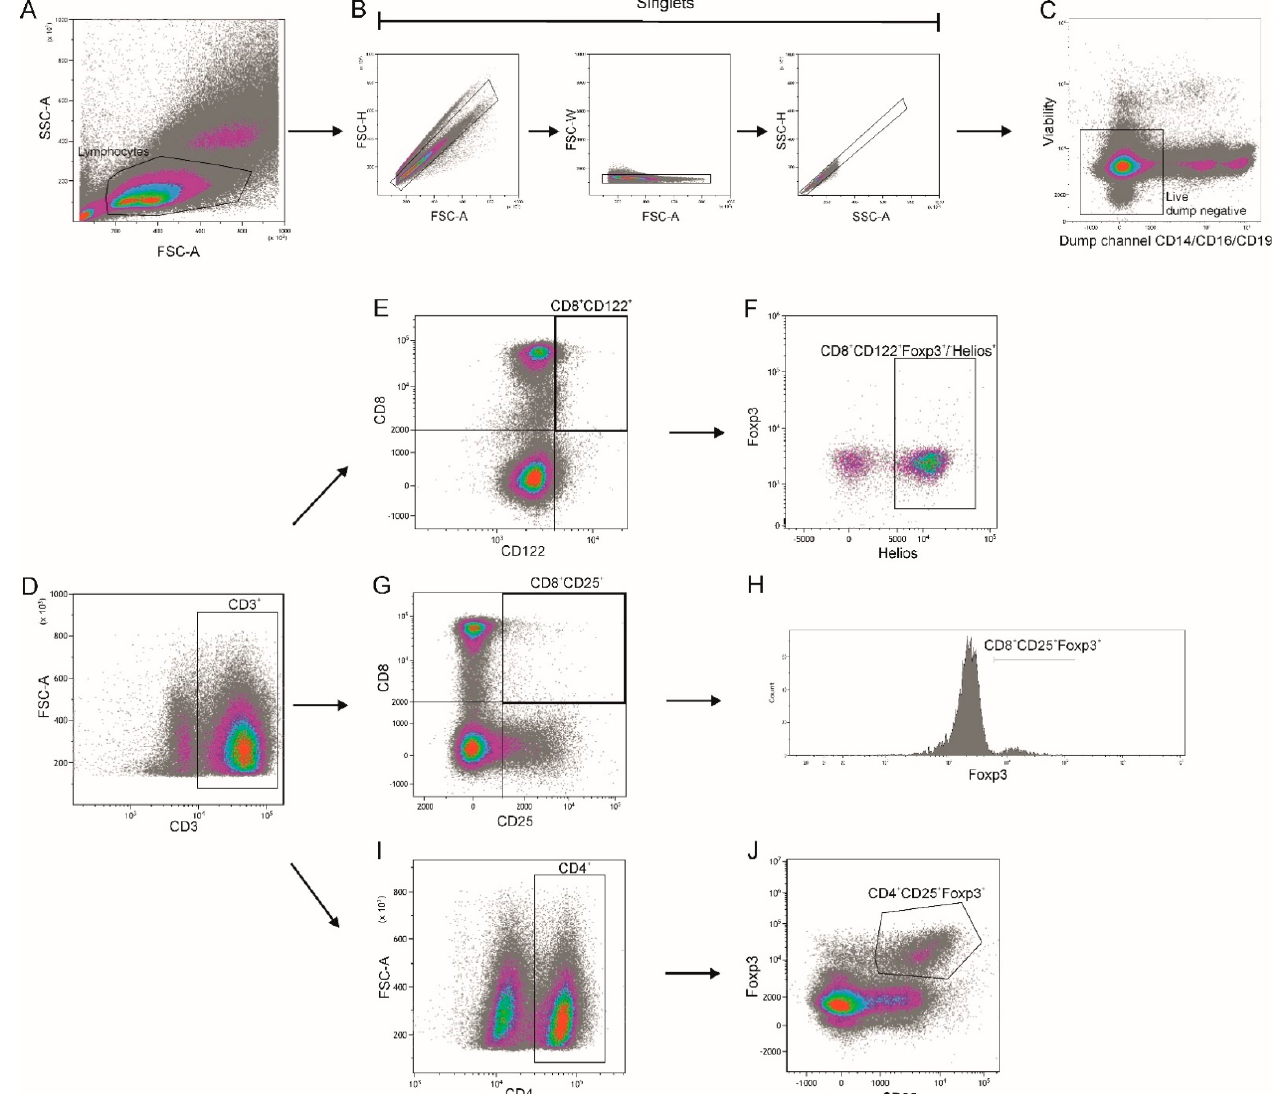
Figure 1. Gating strategy for CD4+ and CD8+ Treg populations. Gating strategy for flow cytometric analysis of lymphocyte population to identify CD4+CD25+FoxP3+, CD8+CD25+FoxP3+ and CD8+CD122+Helios+ Tregs. A time gate was initially applied to exclude any electronic noise and artifacts (not shown here). Next, based on size and granularity, lymphocytes were gated in a forward scatter area (FSC-A) versus side scatter area (SSC-A) plot ( A ). Then, doublet cells were excluded using FSC-A/FSC-height (FSC-H), FSC-A/FSC-Width (FSC-W) and SSC-A/SSC-height (SSC-H) parameters ( B ). Next, viable lymphocytes were gated and cells that expressed monocyte, NK cell and B cell lineage markers CD14, CD16 and CD19, respectively were excluded (“dump channel”, dump negative gate) ( C ), followed by expression of CD3 ( D ). CD8+CD122+Helios+ Tregs were identified as CD8+CD122+ cells ( E ) with FoxP3 +/ − and Helios co-expression ( F ). CD8+CD25+FoxP3+ Tregs were identified by CD8 and CD25 ( G ) and Foxp3 ( H ) expression. CD4+CD25+FoxP3+ Tregs were identified as CD4 + CD25 + FoxP3 + cells ( I , J ). Representative plots are presented. The mean percentage of CD8+CD122+Helios+ cells was 53.1 ± 3.15. The distribution was slightly left-skewed but not significantly different from a normal distribution. There was no significant difference between patients and controls in the percentage of CD8+CD122+Helios+ cells ( p = 0.211); similarly, there was no detectable effect of age ( p = 0.973) but there was a higher percentage of CD8+CD122+Helios+ cells in females (64.5 ± 4.0) than males (43.9 ± 4.7; p = 0.005). Within patients, the number of CD8+CD122+Helios+